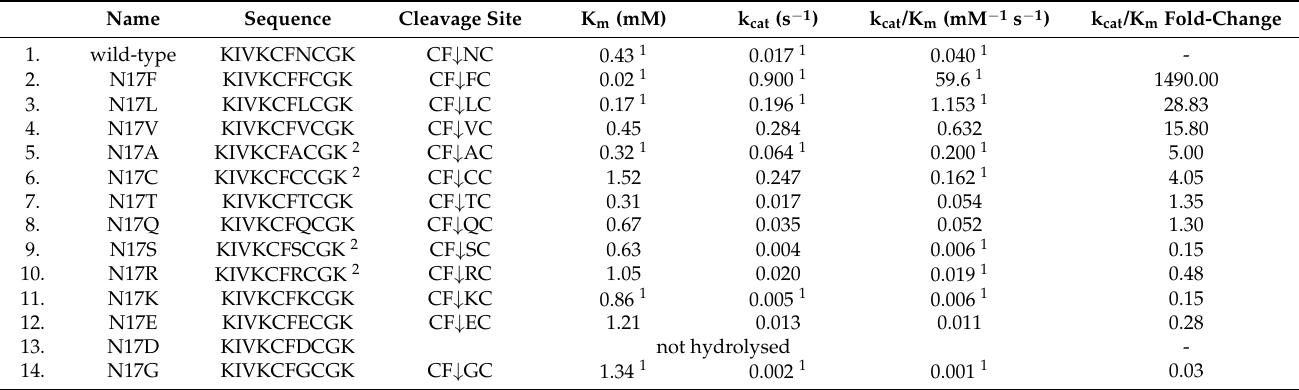
Table 2. Proteolytic processing of substituted oligopeptides representing the first cleavage site in the HIV-1 NC. The table shows the wild-type and P1 (cid:48) single mutant oligopeptides. Modified positions are highlighted with a grey background. The fold-change of k cat /K m values is also indicated.